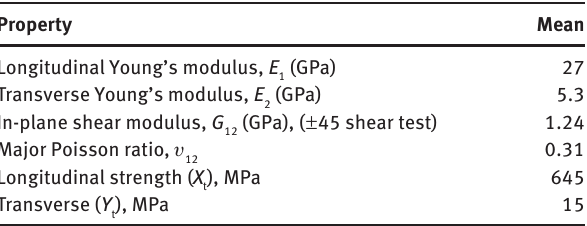
Table 3 Elastic properties of composite laminate (experimentally evaluated not described